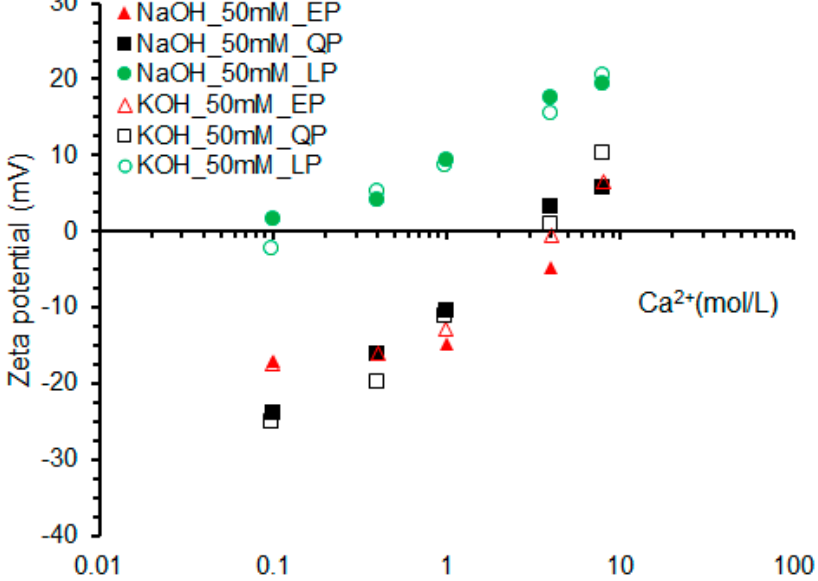
Figure 9. Zeta potentials of EP, QP and LP with Ca 2+ concentration in 50 mmol/L NaOH and KOH solutions.